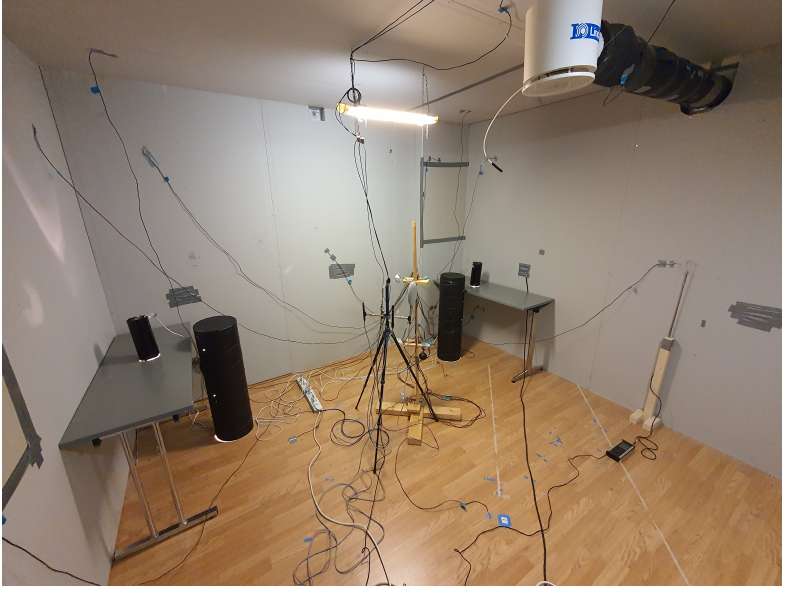
Figure 2. Climate chamber of the experimental study